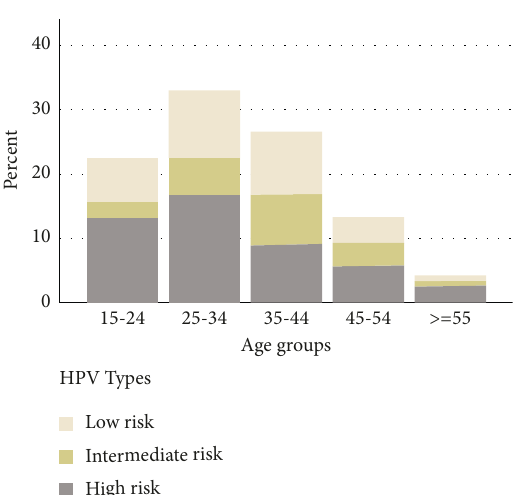
Figure 1: Prevalence of different HPV genotypes.